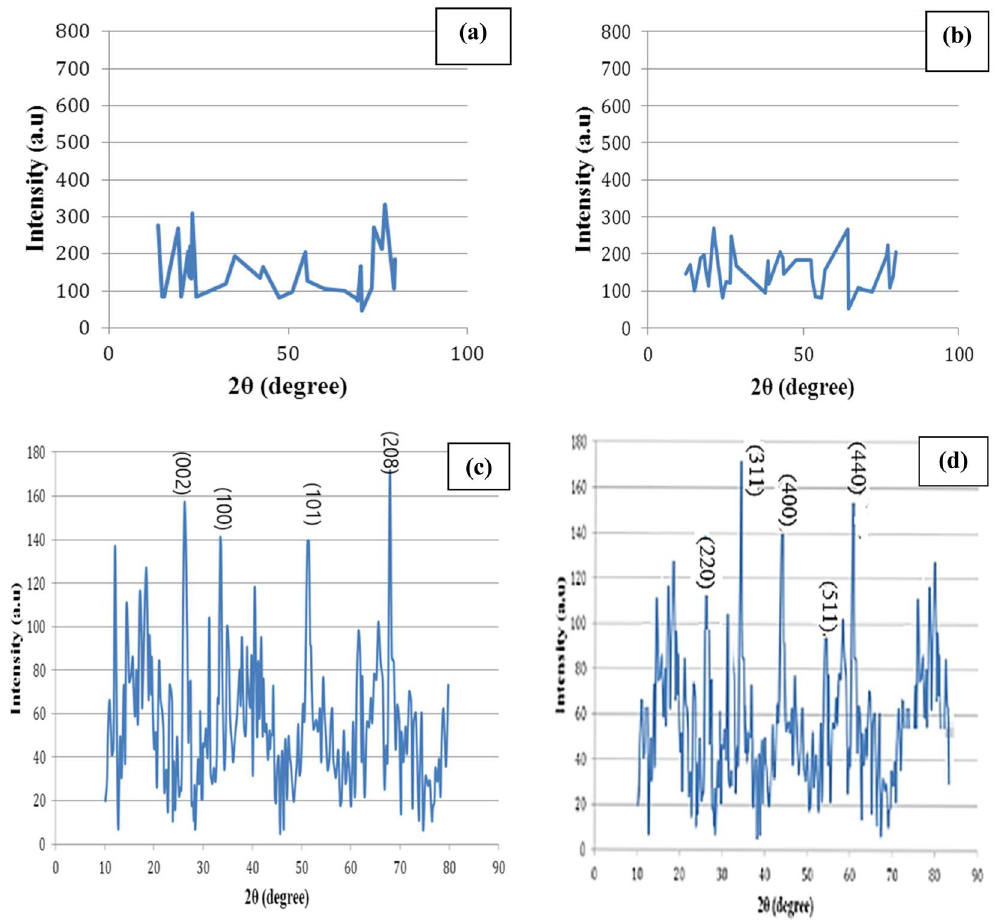
Figure 2. X-ray diffraction pattern (XRD) of the two raw water hyacinth segments, raw shoots and roots and the prepared activated carbon: ( a ) shoots segment, ( b ) roots segments, ( c ) activated carbon product, ( d ) magnetic activated carbon